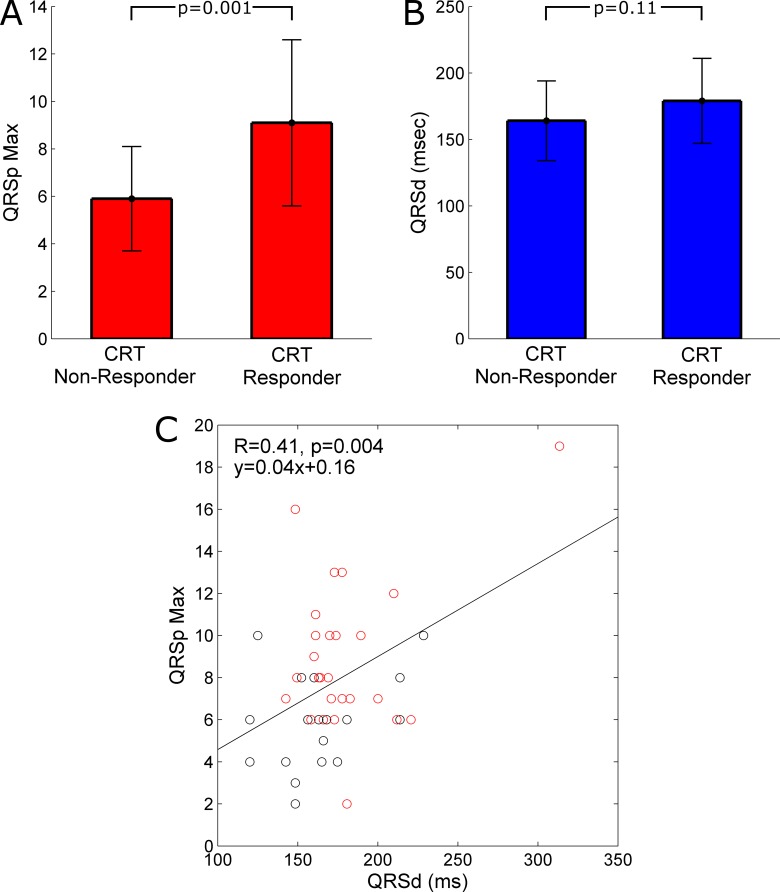
Comparison of QRSp and QRSd between CRT response groups (N = 47).Bar graphs comparing (A) QRSp Max and (B) QRSd between CRT responders and non-responders. (C) Scatter plot illustrating a significant (p<0.004) but weak (R = 0.41) linear correlation between the baseline QRSp Max and QRSd for all 47 CRT patients. The 28 CRT responders are highlighted with red circles.